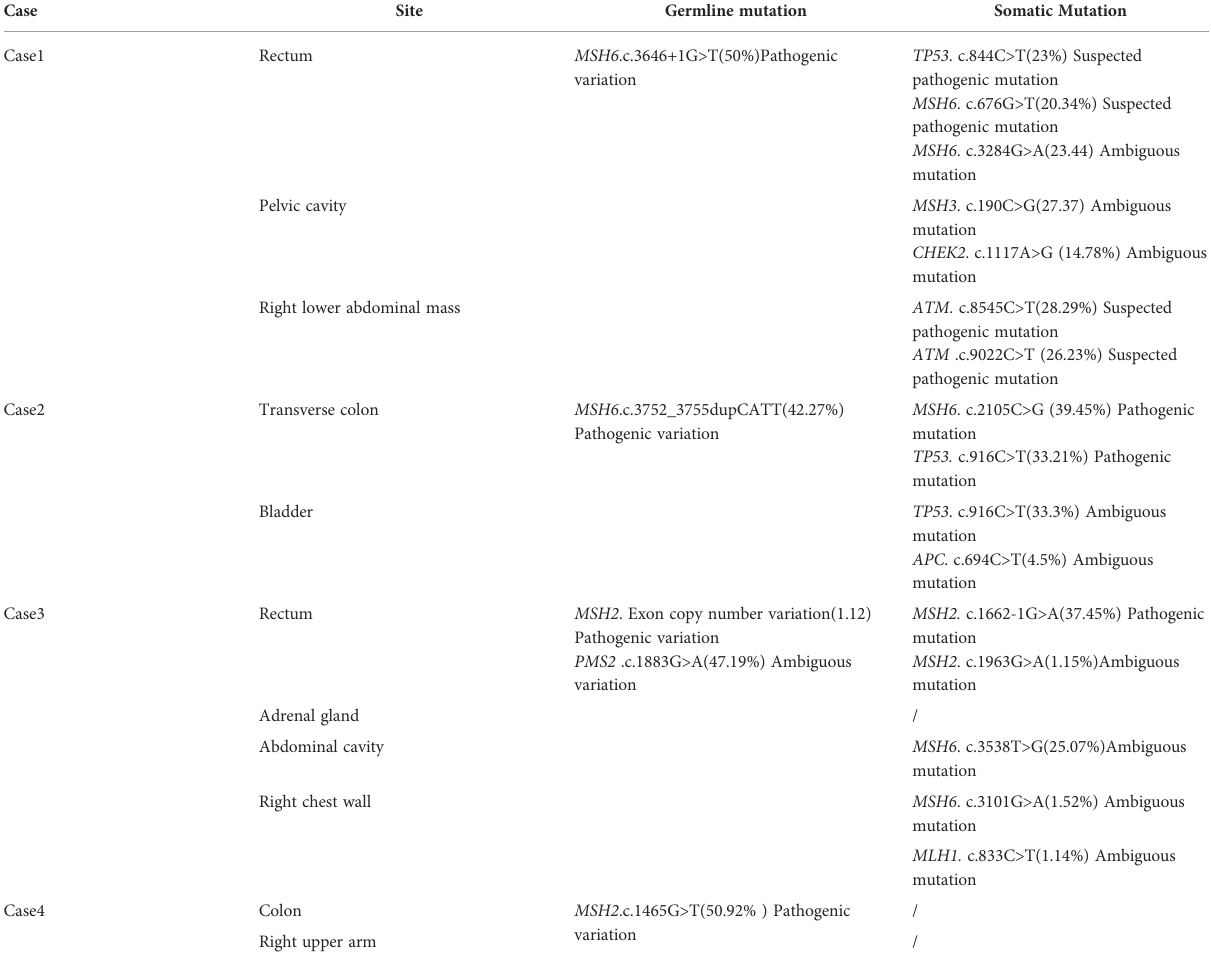
TABLE 2 Summary of germline variations and somatic mutations of mismatch repair